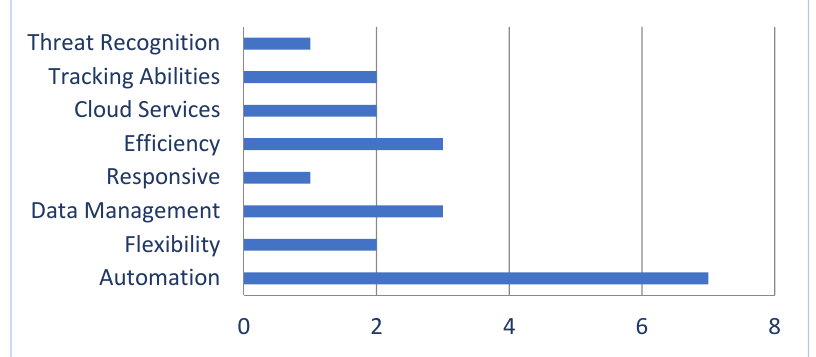
Figure 4. Summary of the frequency of current distinctive characteristics.